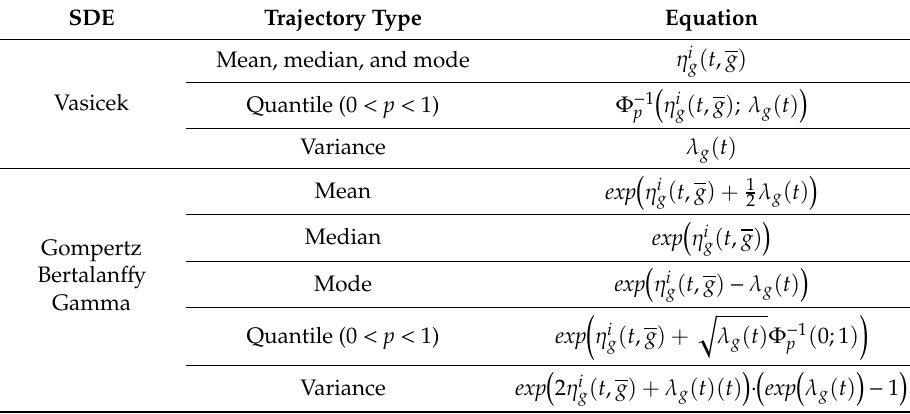
Table 4. Marginal mean, median, mode, p -quantile (0 < p < 1), and variance trajectories.